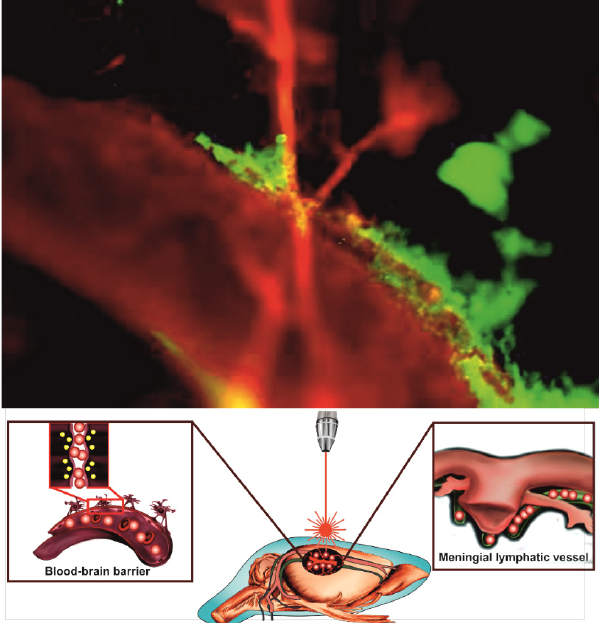
Fig. 5. (Color online) Fluorescent microscopy of clearance of FITC-dextran (red color) from the brain via the meningeal lymphatic vessels (green color, labelled by speci¯c antibodies LYVE-1 conjugated with Alexa 488). The FITC-dextran injected intravenously immediately is observed in the Sagittal sinus (the main cerebral vein) and after PDT-opening of the BBB it is also presented in the meningeal lymphatic vessels due to activation of clearance of FITC-dextran from the brain parenchyma.